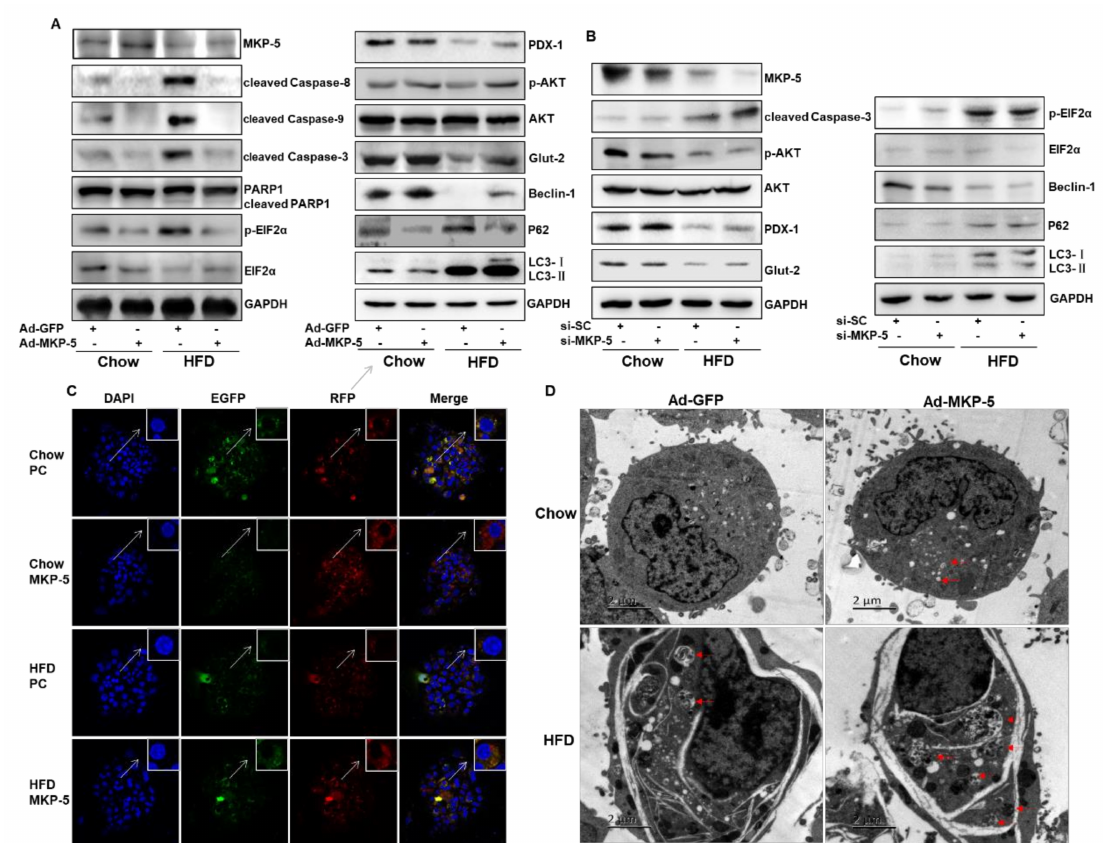
Figure 6. MKP-5 mediates obesity-induced apoptosis, ERS, dysfunction, and autophagy inhibition in primary mouse islet cells. A, B. Mouse primary islet cells were isolated from HFD or chow diet-fed mice and then infected with Ad-MKP-5 / Ad-GFP ( A ) or transfected with si-SC / si-MKP-5 ( B ) (male mice, n = 7 per group). Then, the expression of MKP-5, apoptotic proteins, ERS-related proteins, islet cell functional proteins, and autophagy-related proteins were analyzed by Western blotting. ( C ) Autophagy was monitored in primary islet cells transfected with ptfLC3 and pcDNA3.1 / pcDNA3.1-MKP-5 for 72 h. LC3-labeled representative fluorescent images were observed by confocal fluorescence microscopy. ( D ) Autolysosomes indicated by red arrows in primary islet cells from HFD or chow diet-fed mice were observed by TEM (scale bar = 2 µ